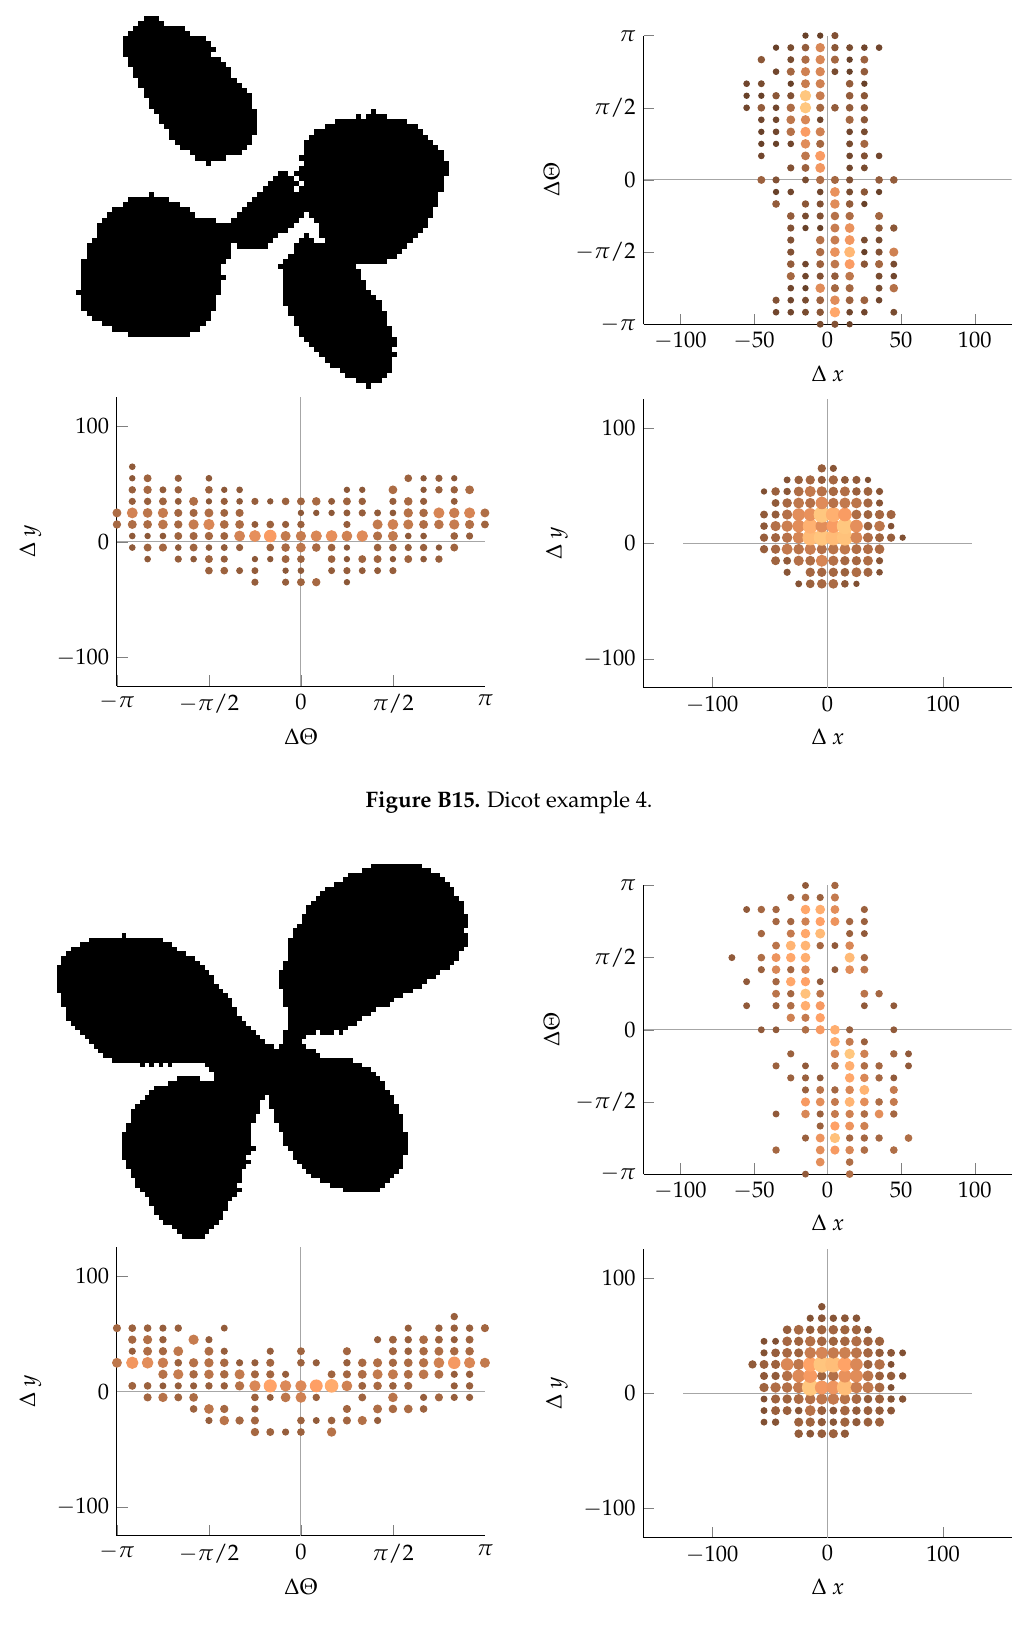
Figure B16. Dicot example